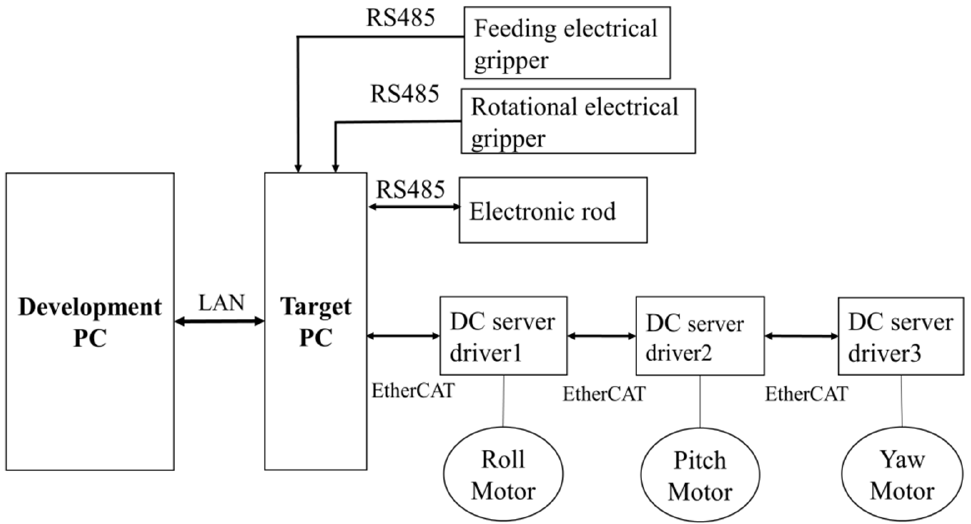
Figure 5. Overall control system architecture of the forming robot.